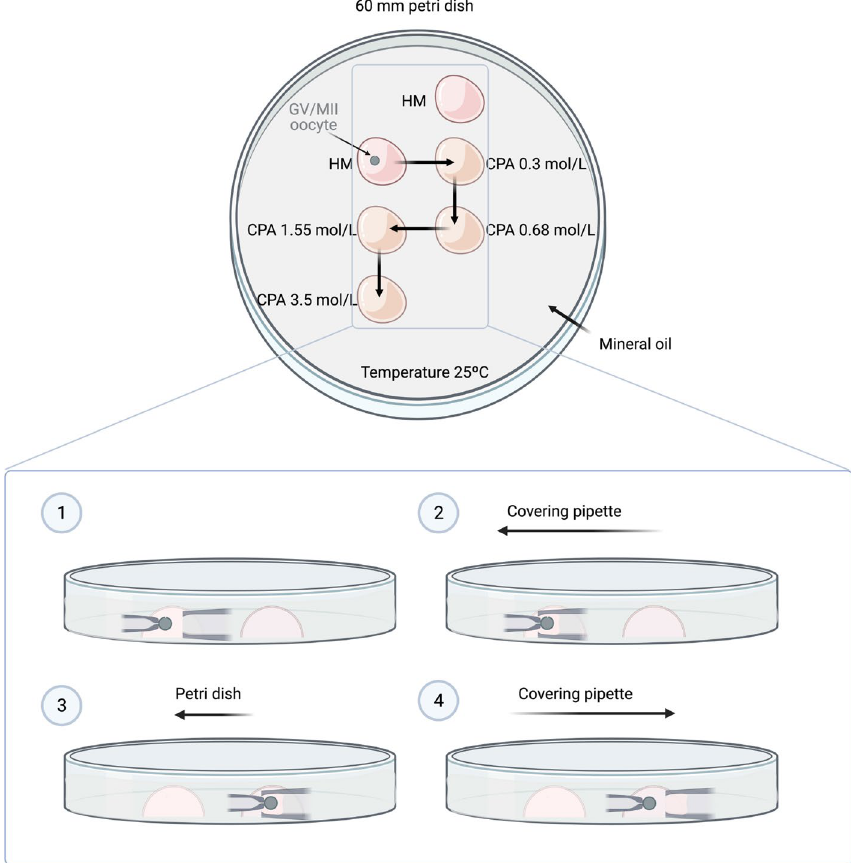
Figure 6. Schematic representation of the device and the procedure for direct transfer of GV or MII oocytes (solid circle) to an increasing CPA exposure (right hemisphere) from isotonic holding medium (left hemisphere) using a micromanipulator